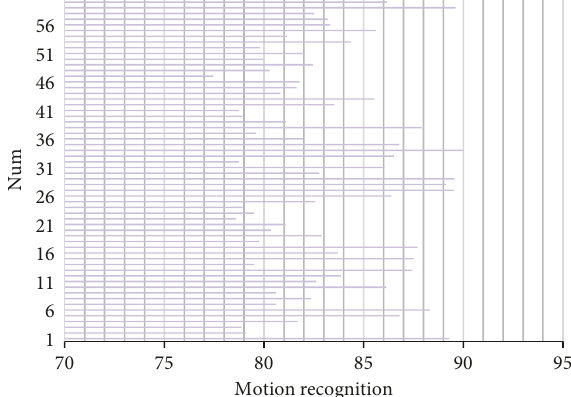
Figure 8: Statistical diagram of the recognition effect of the motion pattern recognition model based on artificial visual neural